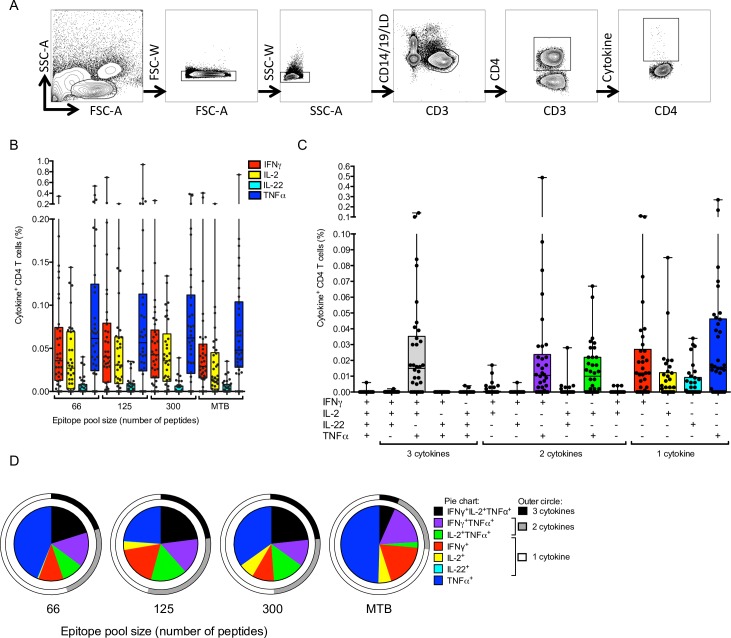
Characterization of CD4 T cell responses using epitope pools.(A) Gating strategy for ICS assay. SSC-A; Side-scatter area, FSC-A; Forward-scatter area, SSC-W; Side-scatter width, FSC-W; Forward-scatter width, LD; Live/Dead discrimination. (B) Percentage cytokine detected from CD3+CD4+ T cells in response to the pool of 66, 125 and 300 epitopes, as well as heat killed H37Rv Mtb lysate. Each dot represents one donor (n = 34) median ± interquartile range is indicated. (C) Percentage Epitope pool-specific (125 epitopes) IFNγ, TNFα, IL-2 and IL-22 production by CD3+CD4+ T cells expressing each of the fifteen possible combinations. Each dot represents one donor (n = 34) median ± interquartile range is indicated. (D) The fraction of the total cytokine response against each stimuli expressing each combination of cytokines (pie chart) and all 4, 3, 2 or 1 cytokine (outer circle).